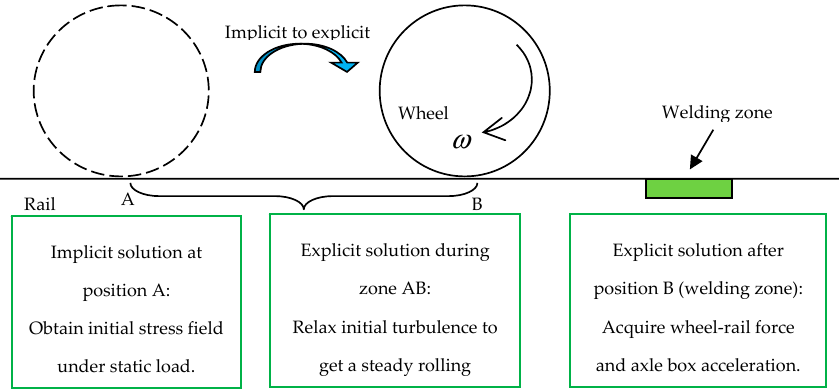
Figure 9. Schematic diagram of the simulation process.